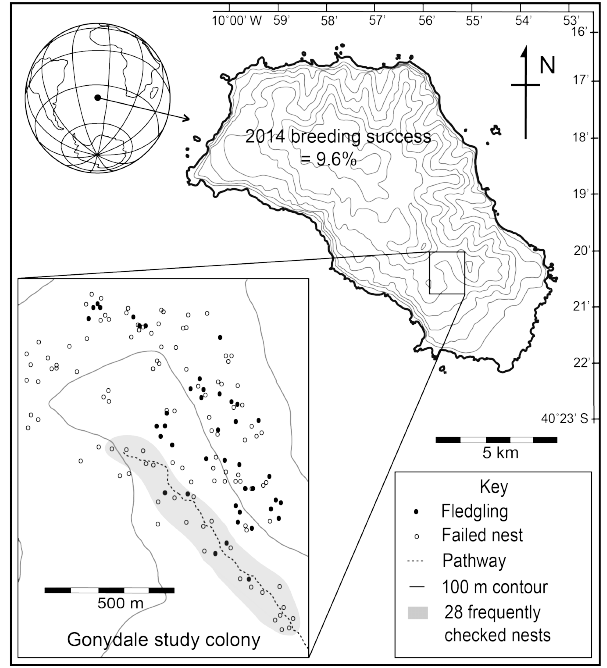
Fig. 1 . Gough Island showing the location of the long-term Tristan Albatross ( Diomedea dabbenena ) study colony in the Gonydale Valley. Inset shows the location of all nests in 2014 and the shaded area along the pathway where 28 nests were monitored frequently during the early chick